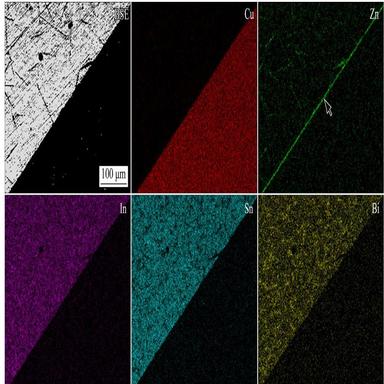
EM-BSE image and corresponding EDX mapping of (Sn0.85Zn0.5)57(In0.78Bi0.22)43 solder alloy